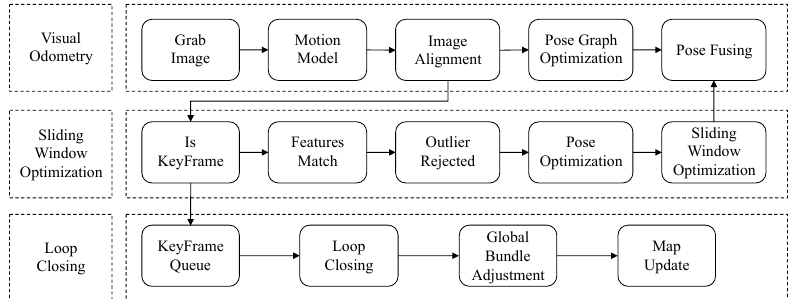
Figure 1. System